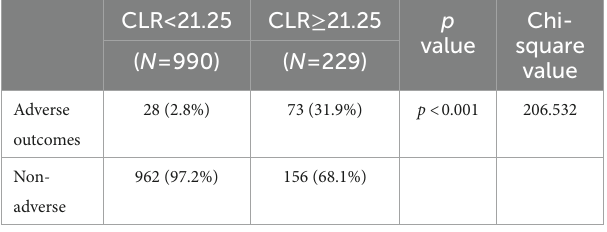
TABLE 4 Association between CLR and clinical outcomes. TABLE 5 Correlation between CLR and the risks of adverse clinical